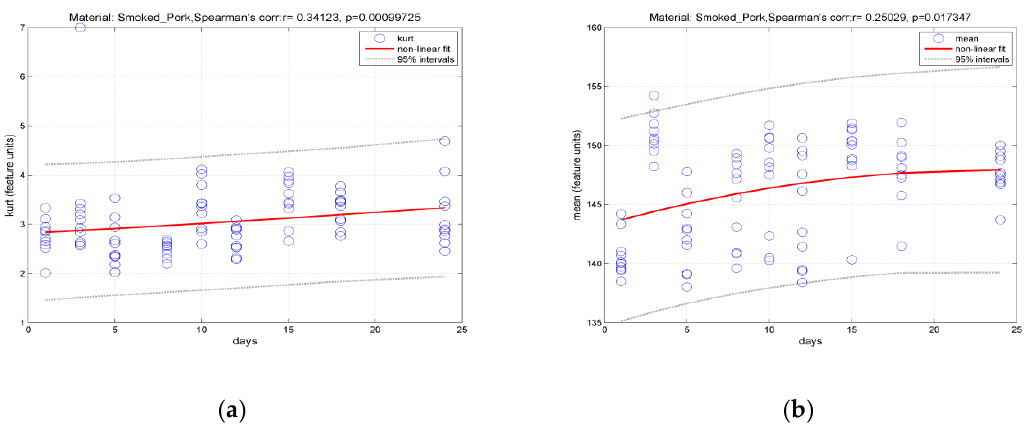
Figure A1. Variation of features ( a ) kurtosis and ( b ) mean intensity value of boiled pork hams during refrigerator storage.